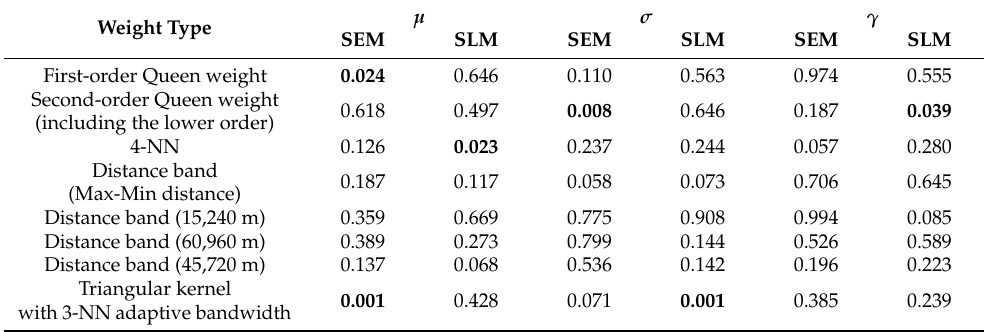
Table 3. Summary of the p -values for each spatial regression model (the significant ones are